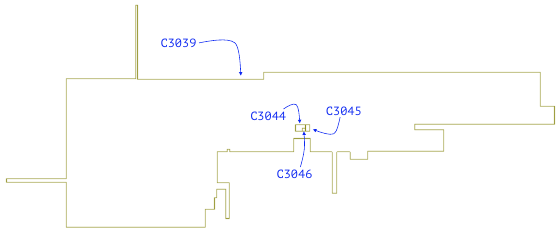
Figure 8. Some cells of nav-demo-201 projected to the 2D plan; the identifiers shown are gml:id of the cells.